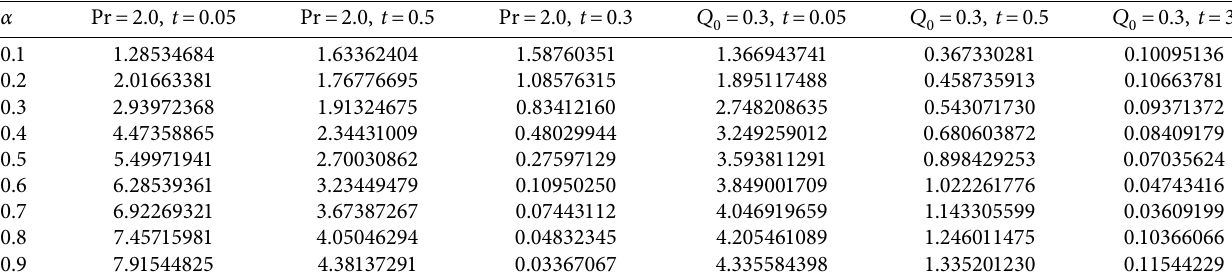
Figure 9: Sketch of velocity profile [ f ( t ) � H ( t ) exp ( iwt ) , g ( t ) � 1 , Gm � 0 ] a comparison with Shah et al. [27]. Table 1: Subjectivity of Nusselt number due to α variation.